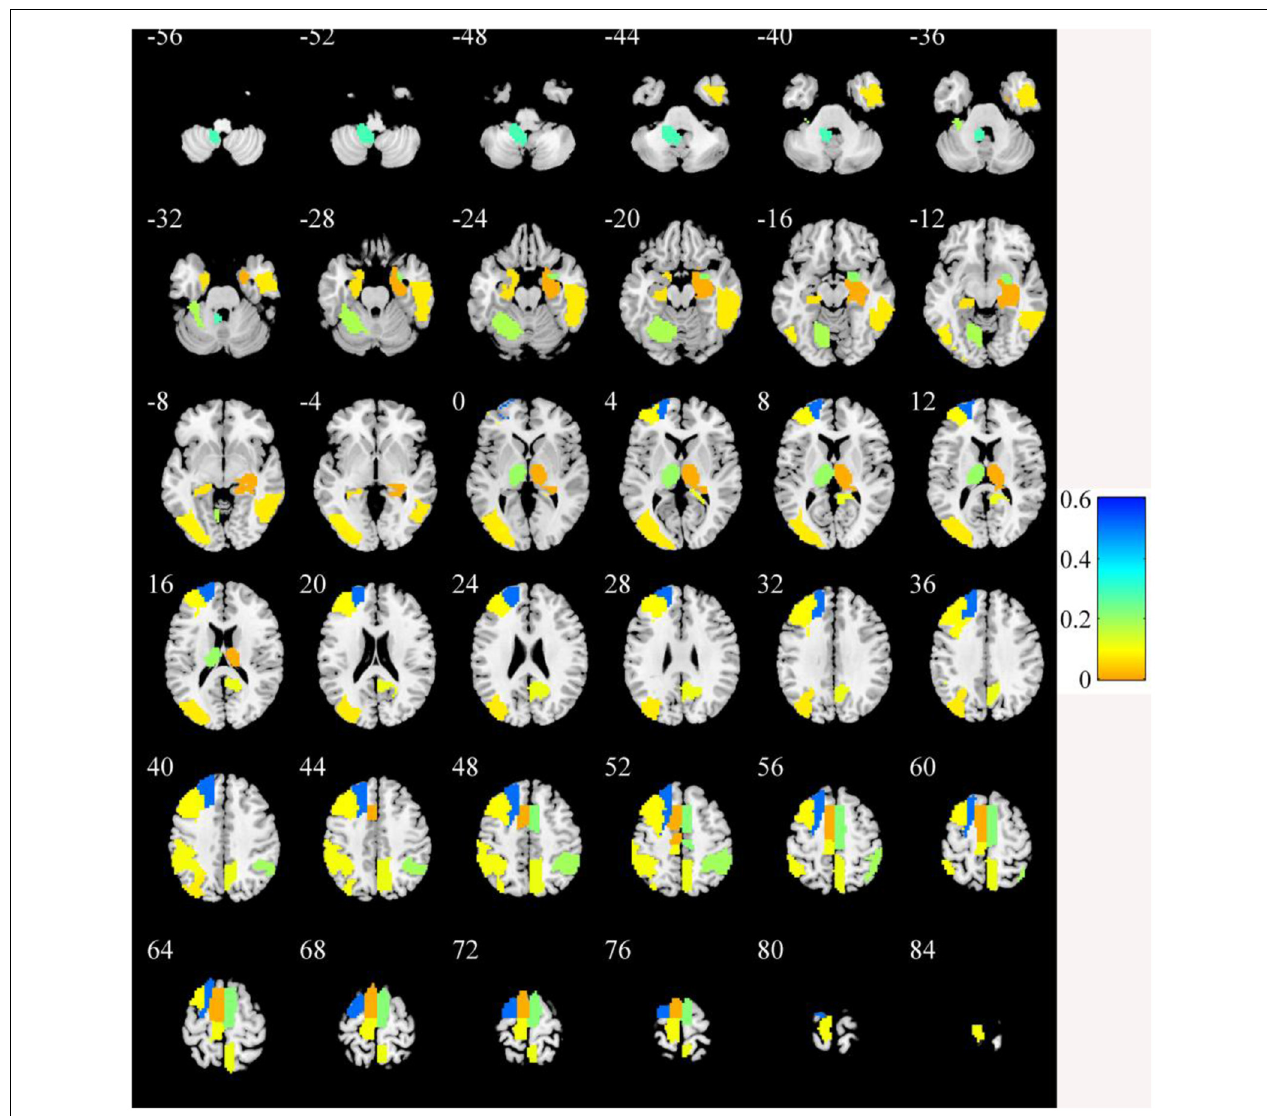
FIGURE 4 | The brain regions of the selected features. The color bar value represents the feature weight